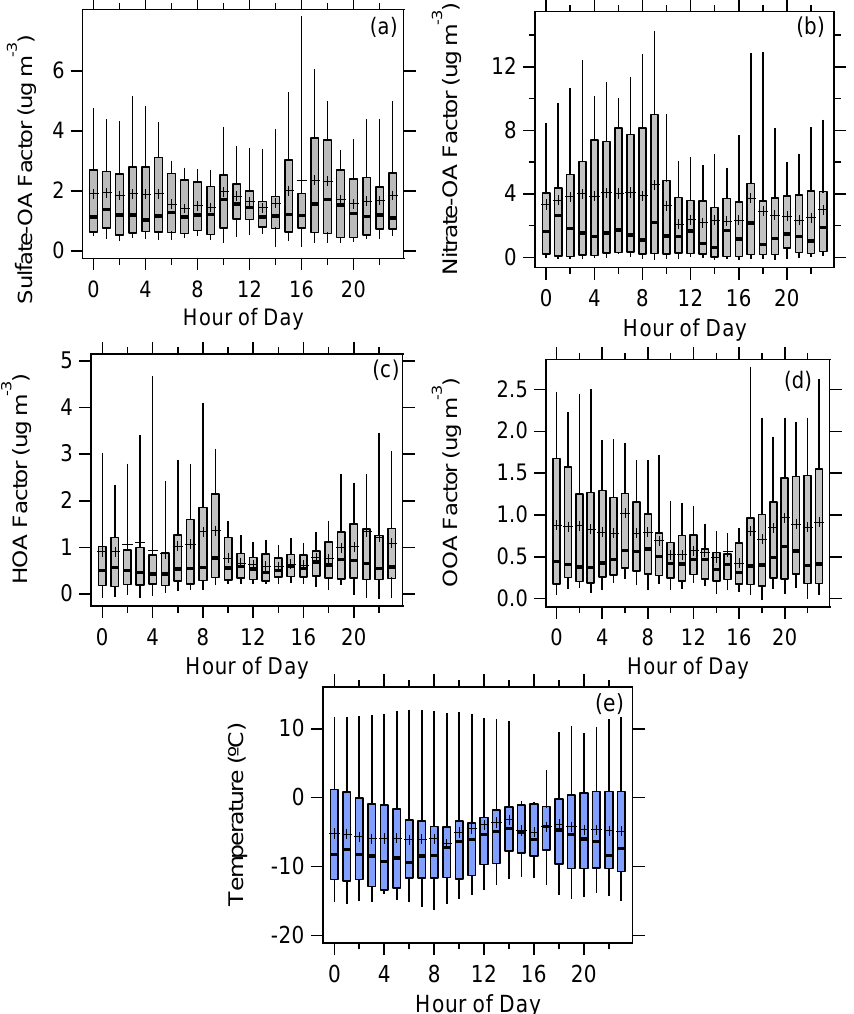
Figure 11. Boxplots of diurnal trends for the Sulfate-OA (a) , Nitrate-OA (b) , HOA (c) , and OOA (d) factors, from the PMF Full MS analysis, along with temperature (e) . Boxes indicate interquartile ranges, horizontal lines indicate median hourly values, cross markers indicate hourly means, and whiskers represent the 5th and 95th percentiles. The HOA factor demonstrated a strong diurnal trend consistent with traffic patterns, while the OOA factor demonstrated a trend more consistent with daytime lows and overnight highs. The Nitrate-OA factor showed a minor diurnal trend indicative of more regional contributions as compared to OOA, while the Sulfate-OA factor showed a minimal diurnal